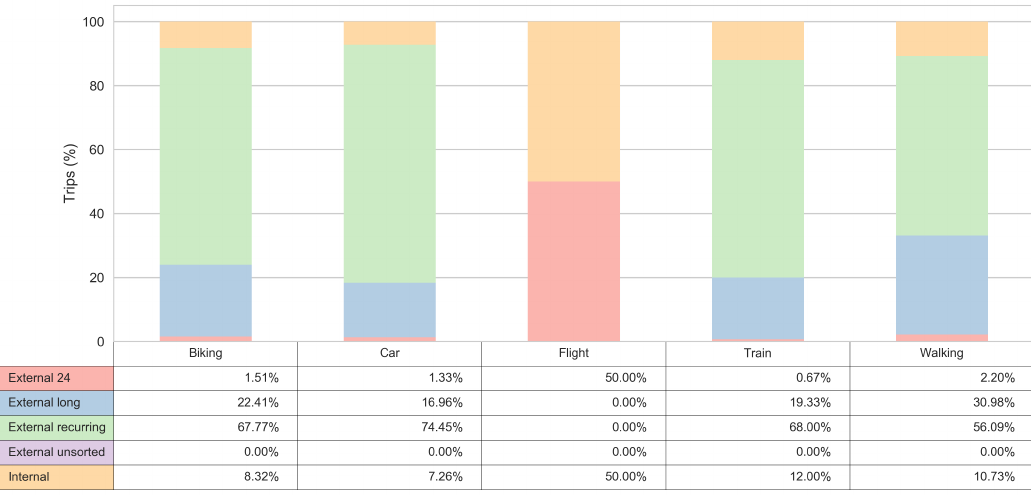
Figure 8. Tourist behaviour by transport